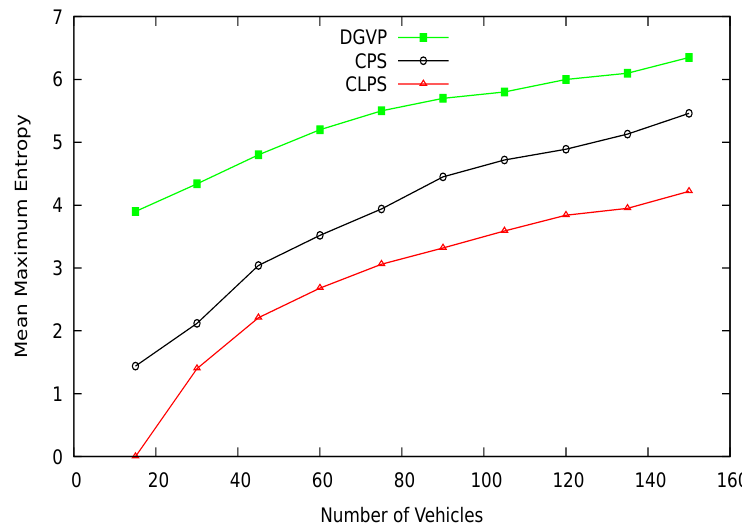
Figure 18. Vehicle entropy at various traffic densities.